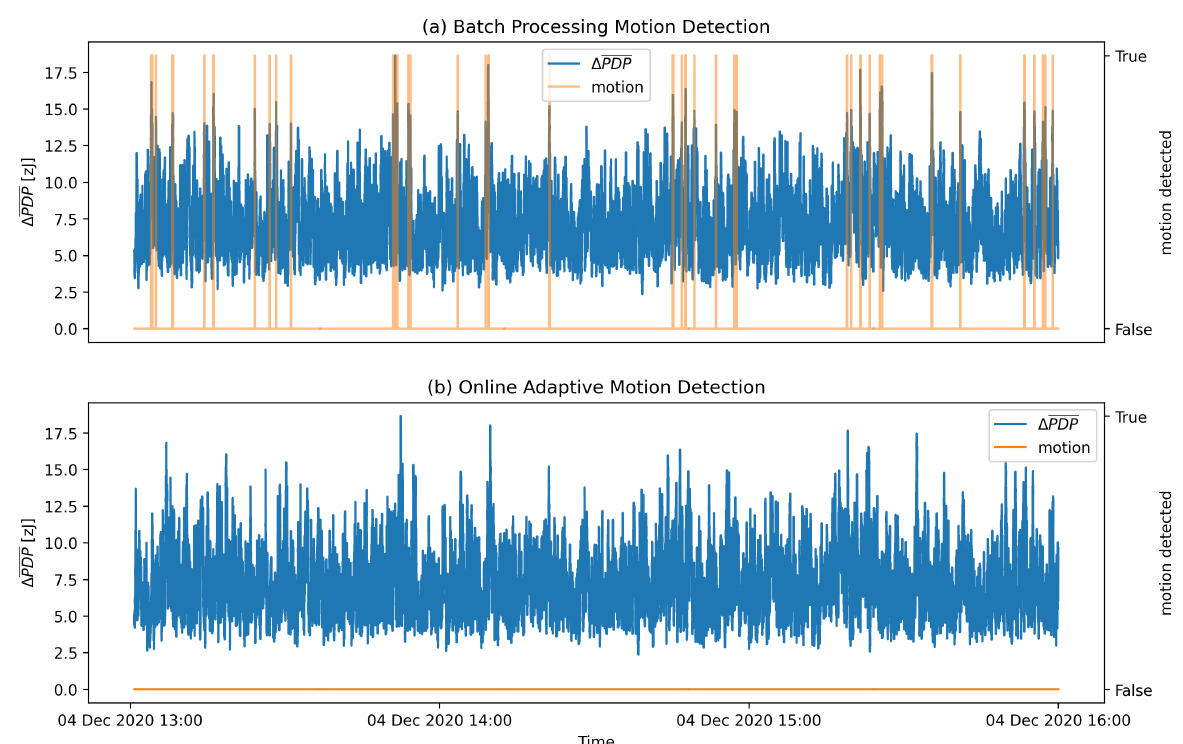
Figure 13. Comparison of motion detection performance of ( a ) batch-processing motion detection and ( b ) OAMD algorithms on identical data stream representing static